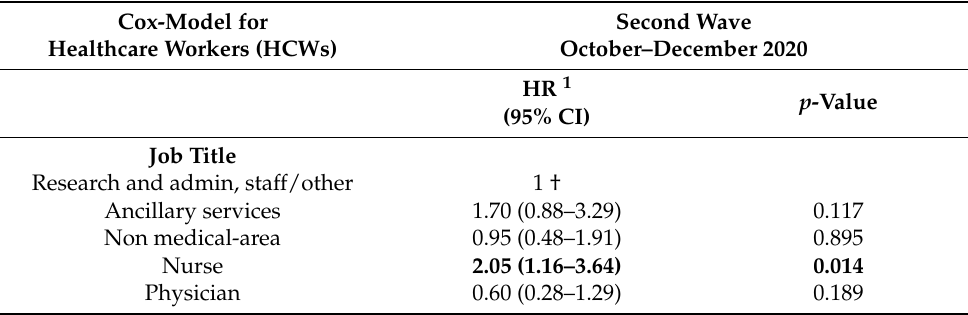
Table 7. Cox-model for HCWs (Healthcare Workers) in the Second pandemic wave. Cox-Model